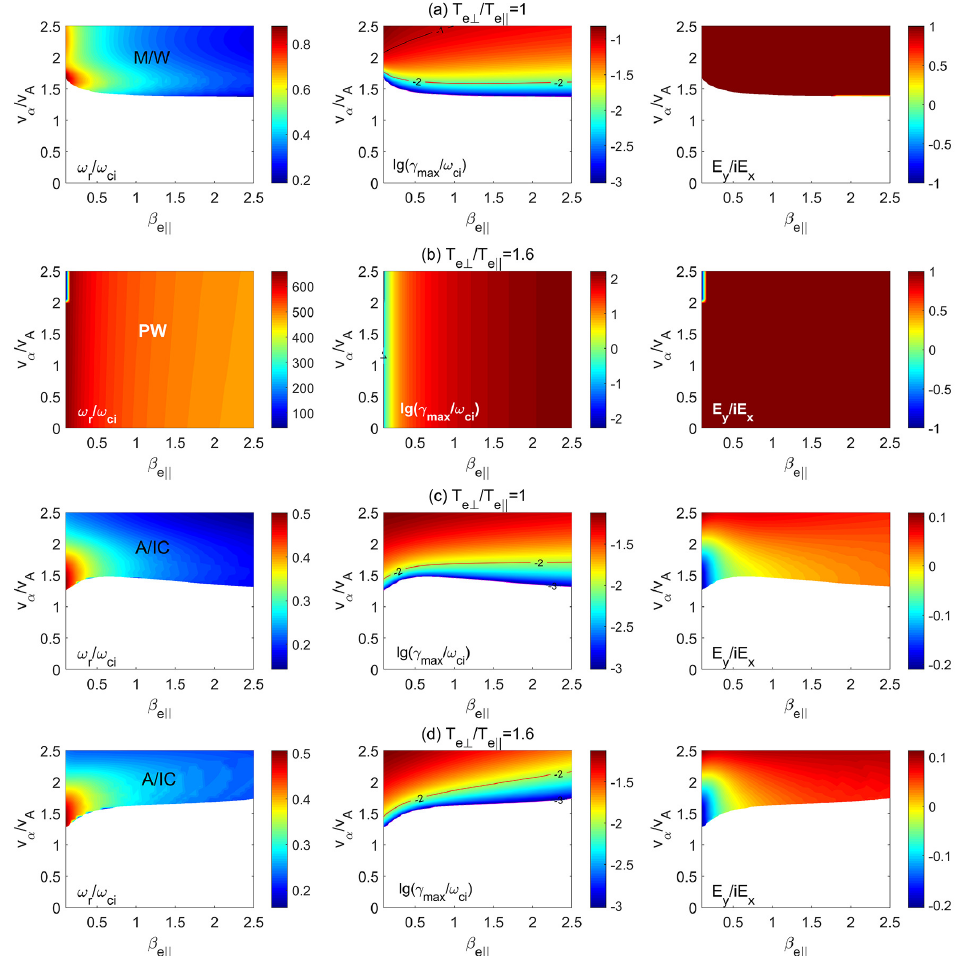
Figure 7. Color bar distributions of the real frequency ( ω r / ω ci ), maximum growth rate ( γ max / ω ci ), and polarization ( E y / iE x ) in the plane of the parallel electron beta ( β e (cid:107) ) and the alpha beam drift velocity ( v α / v A ) for ( a ) T e ⊥ / T e (cid:107) = 1 and θ = 0 ◦ , ( b ) T e ⊥ / T e (cid:107) = 1.6 and θ = 0 ◦ , ( c ) T e ⊥ / T e (cid:107) = 1 and θ = 50 ◦ , and ( d ) T e ⊥ / T e (cid:107) = 1.6 and θ = 50 ◦